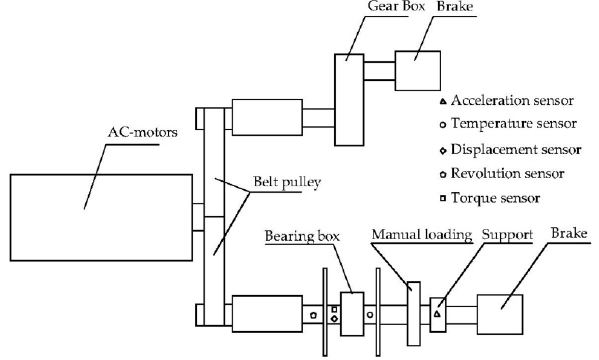
Figure 6. The bearing temperature acquisition and experiment platform.